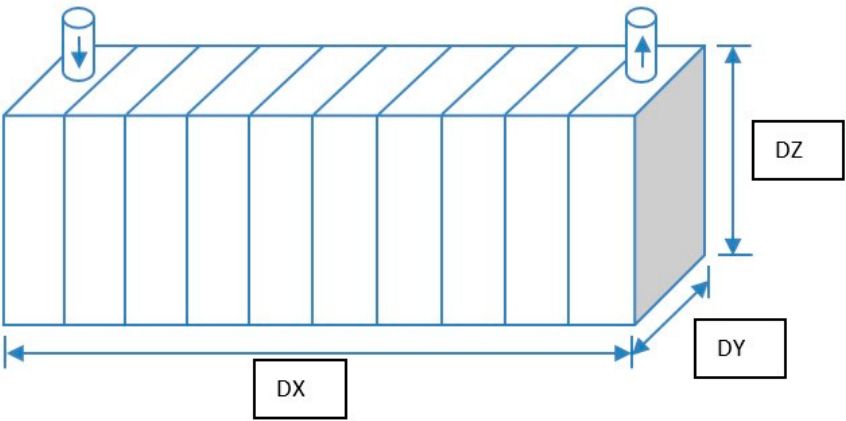
Figure 6. Rectangular core block (10 × 1 × 1).